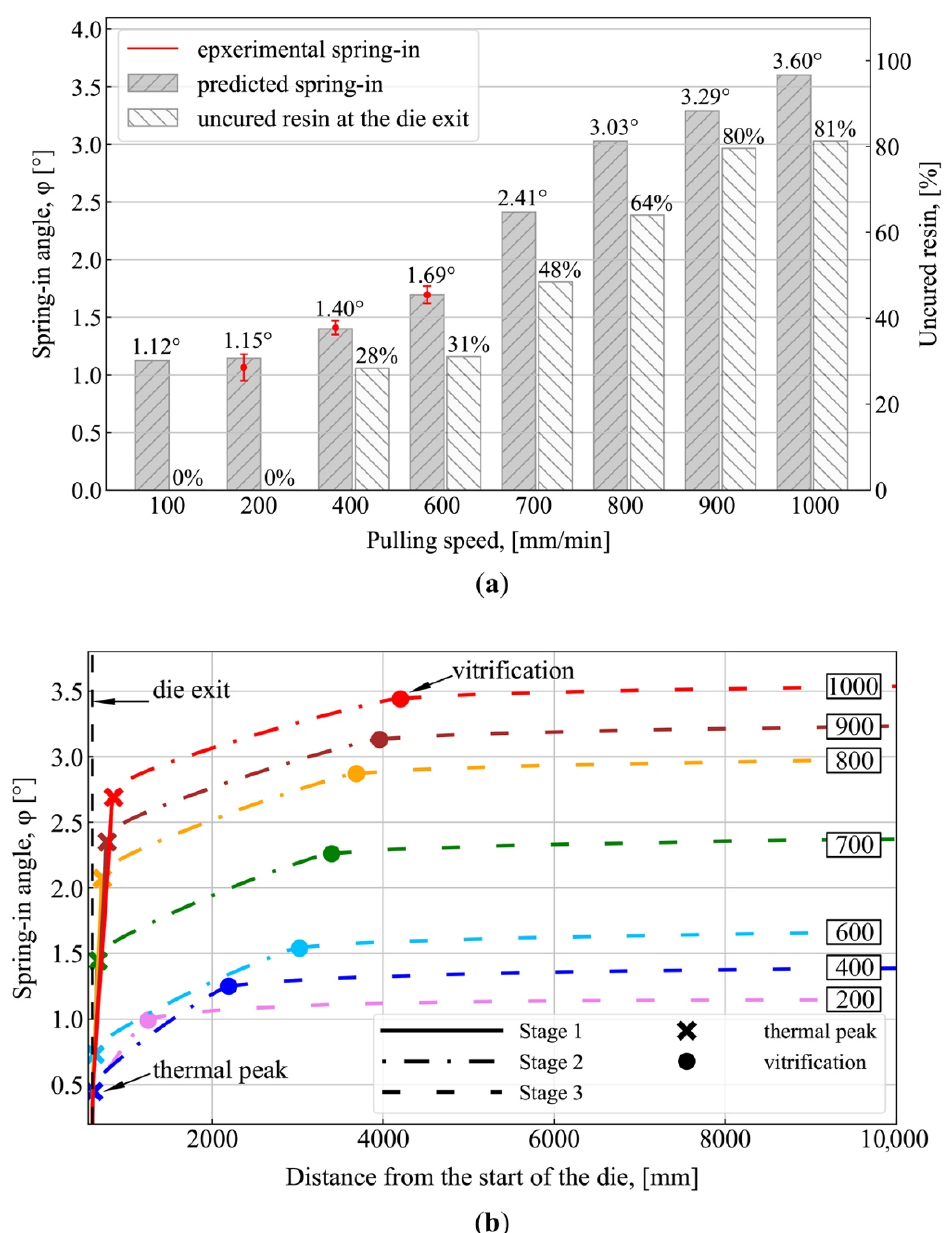
Figure 5. Numerical simulation results: ( a ) Final values of spring-in vs. fraction of uncured resin ( α < 85%) at the die exit for different pulling speeds, obtained with the model described in “Modeling”; ( b ) Spring-in evolution during fabrication for different pulling speeds, obtained with the model described in “Modeling”. The solid lines in ( b ) correspond to Stage I (spring-in evolutions from the moment the profile exits the die block to the exothermic peak occurrence); the dot–dash line corresponds to Stage II (from the exothermic peak occurrence to the vitrification point); the dashed line corresponds to Stage III (after vitrification and to the full cooldown of the profile); the bold cross marks the occurrence of the exothermic peak; the bold point marks the vitrification point; the values shown in rectangles correspond to pulling speed (mm/min).